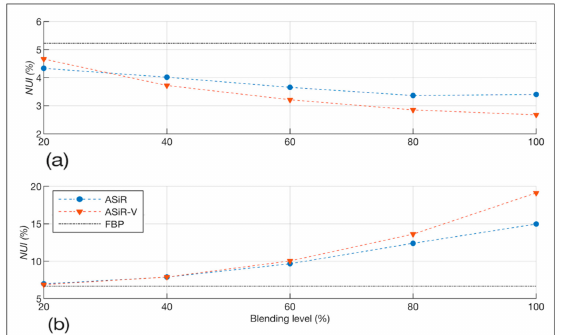
Figure 5. Nonuniformity index ( NUI ) values of noise maps of CT reconstructed images (FBP, ASiR-V, and ASiR) of the CTP486 ( a ) and CTP404 ( b ) phantom modules. For NUI estimation, only the inner part of the phantom (diameter, 15 cm) was considered.